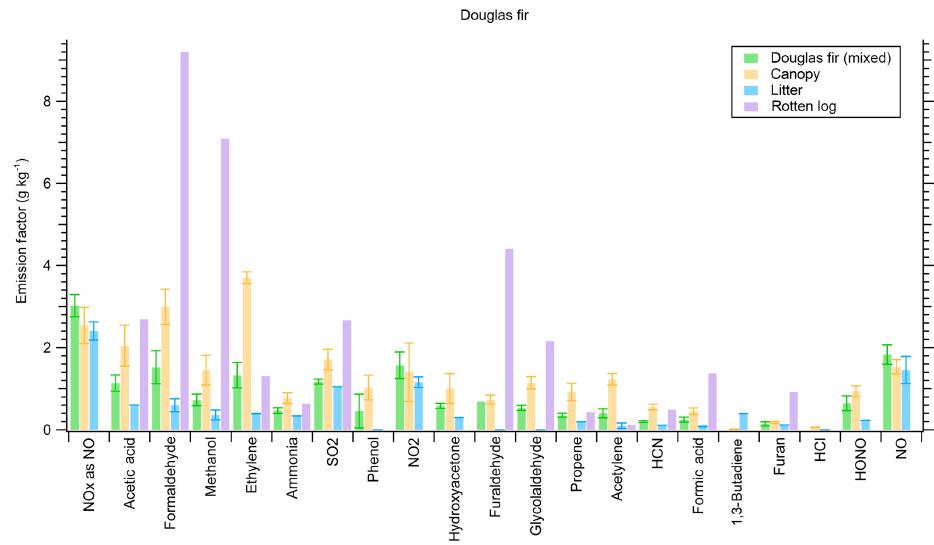
Figure 4. Trace gas emissions from a mixed Douglas fir ecosystem (including sound and dead wood, but rotten log not included) and pure components. Sound dead wood was not burned separately except as untreated lumber.